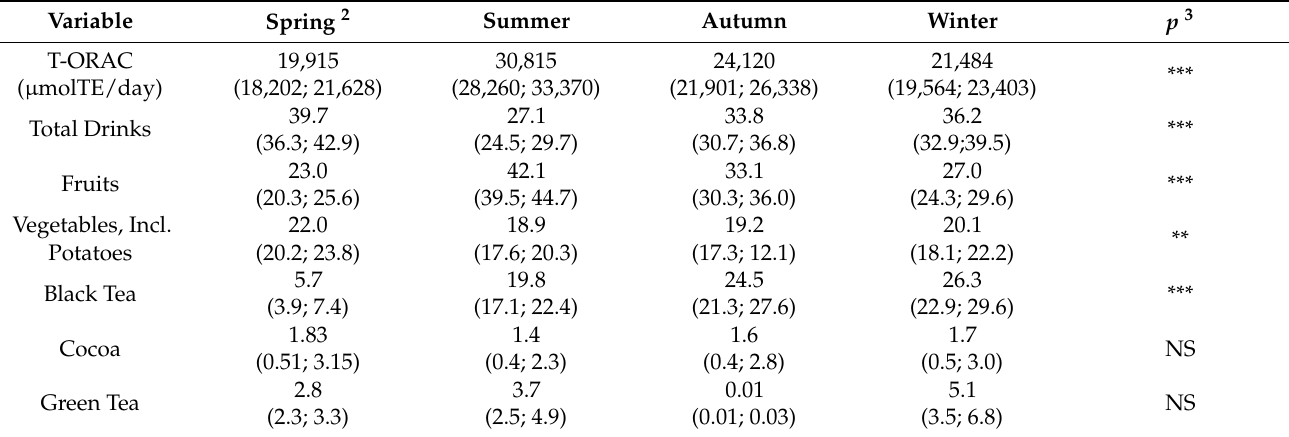
Table 3. The shares (%) of selected foods in the total antioxidant capacity (T-ORAC) of the daily diets in the study group according to seasonality (mean; 95%CI) 1